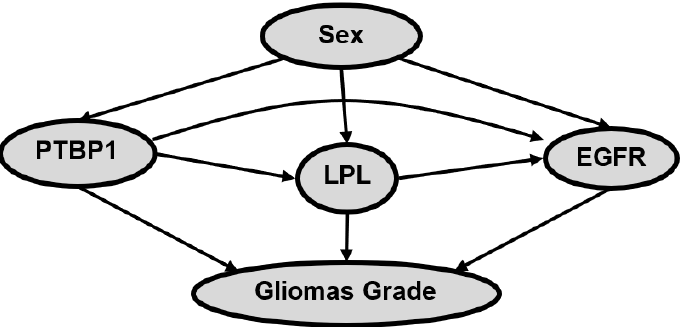
Figure 1. A causal Bayesian networks example .